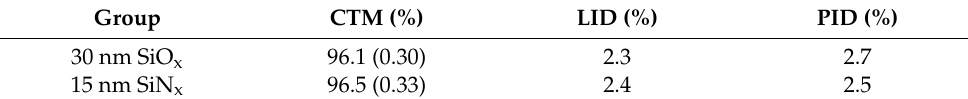
Cell-to-module ratios, light-induced degradation (LID) rates, and potential-induced degradation (PID) rates of monocrystalline silicon PERC solar modules with different third layers of antireflection coating, i.e., 30 nm SiO x and 15 nm SiN x . Mean values and the CTM standard deviation values are listed. The LID test conditions are 1000 W/m 2 , 60 ◦ C, and 60 h. The PID test conditions are